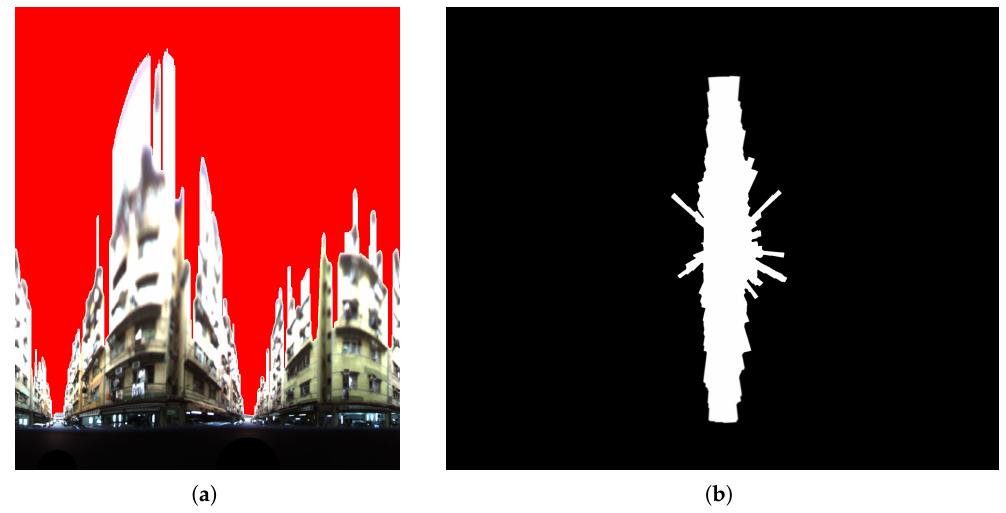
Figure 9. Sky region segmentation results affected by sky reflections. ( a ) Sky region segmentation algorithm results in discontinuous sky boundaries. ( b ) The result of binarization after converting back to the omnidirectional image.